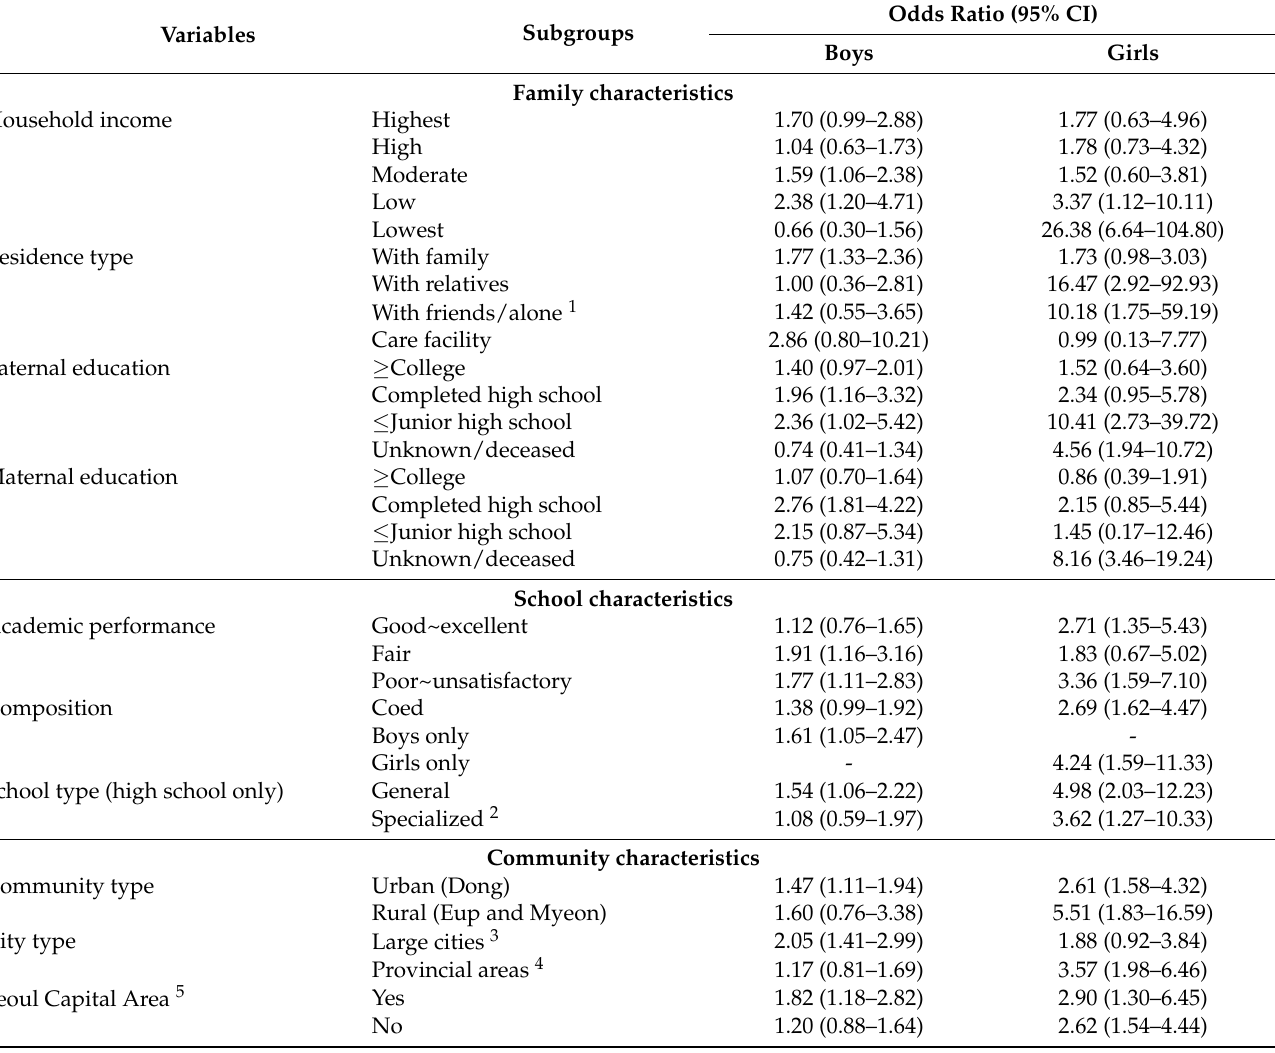
Table 4. Association between early sexual debut and various socio-environmental characteristics, adjusted for grade and survey